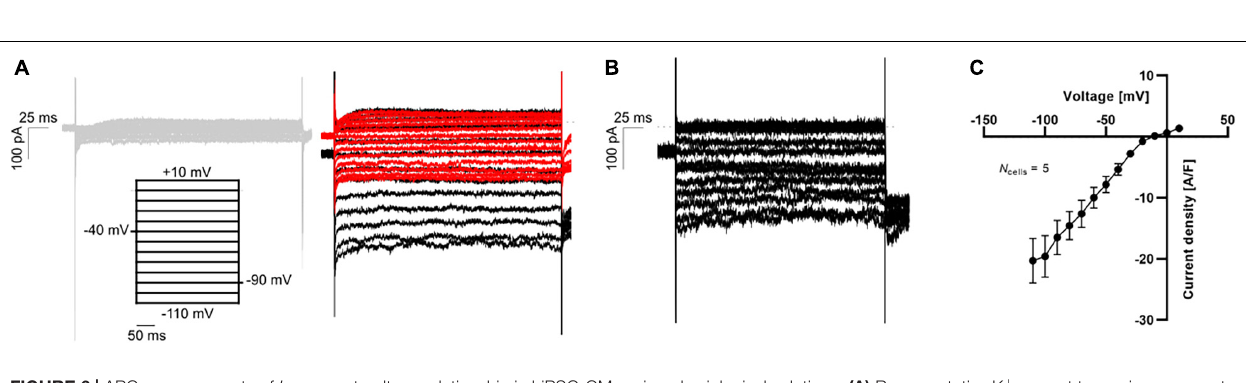
FIGURE 6 | APC measurements of I K1 current-voltage relationship in hiPSC-CMs using physiological solutions. (A) Representative K + current traces in response to a voltage step protocol from –110 mV to +10 mV with 10 mV increment step size (black). The current was measured in 5 mM extracellular K + (gray, left) and 75 mM extracellular K + before (black) and after (red) addition of 1 mM BaCl 2 (right). (B) The BaCl 2 sensitive I K1 was calculated by subtracting the insensitive current (red trace in A ) from the total I K (black trace in A ). (C) The I K1 current-voltage relationship was plotted by extracting the average steady-state sensitive current (shown in B ) and plotting as a function of step voltage. Adapted from Rosholm et al. (2022), with permission from Sophion Bioscience